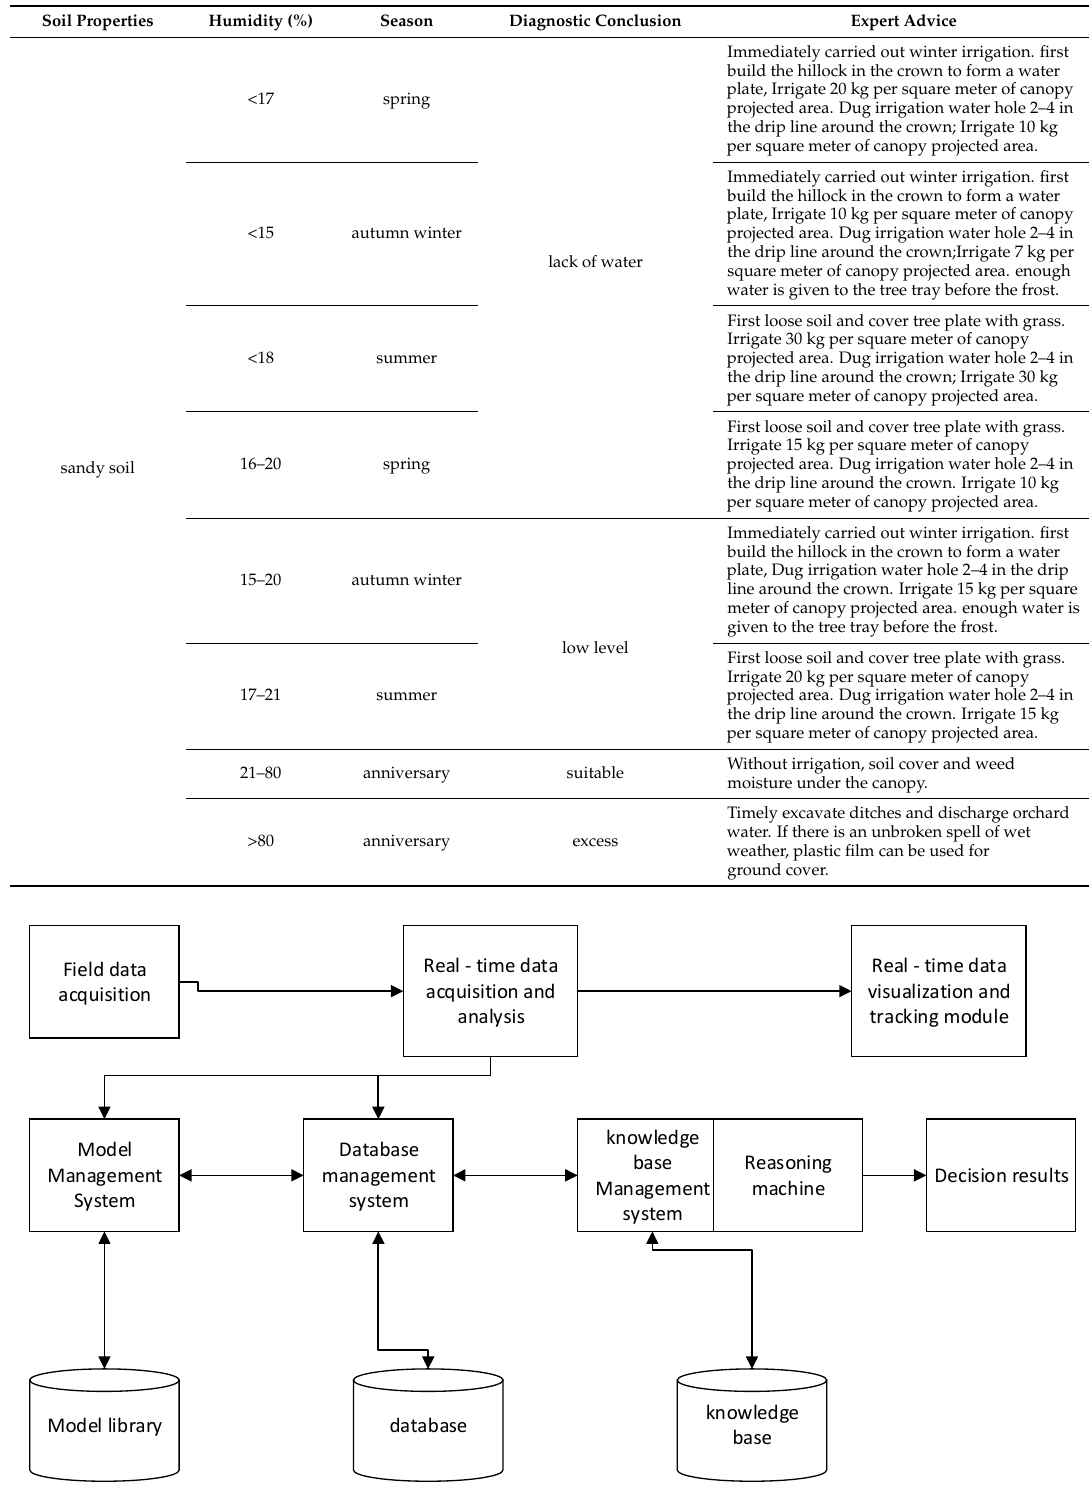
Table 1. Knowledge base of citrus irrigation (sandy soil).